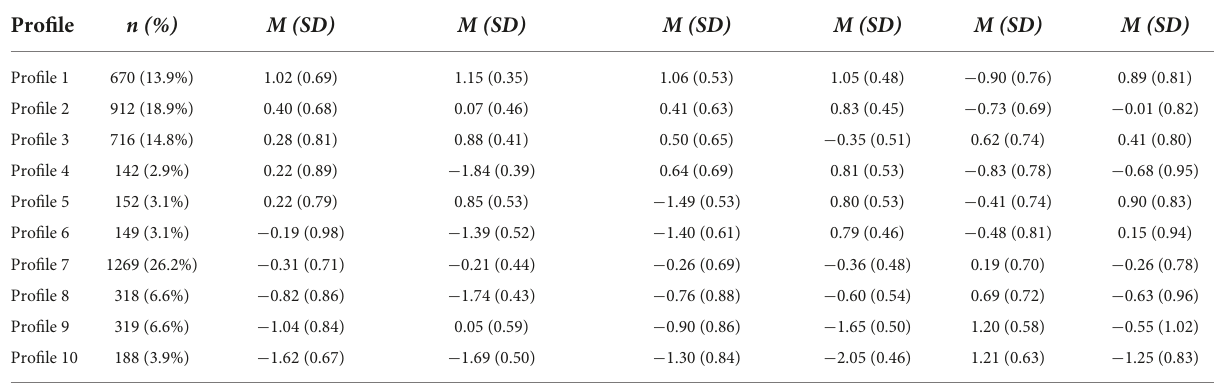
TABLE 3 Standardized descriptive statistics by